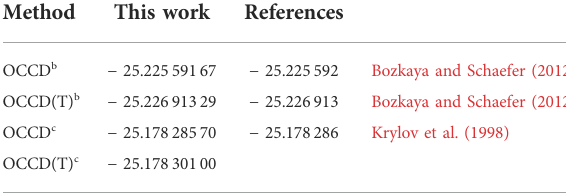
TABLE 1 Comparison of the ground state energy of BH (r e =2.4 bohr) molecule in DZP basis a .